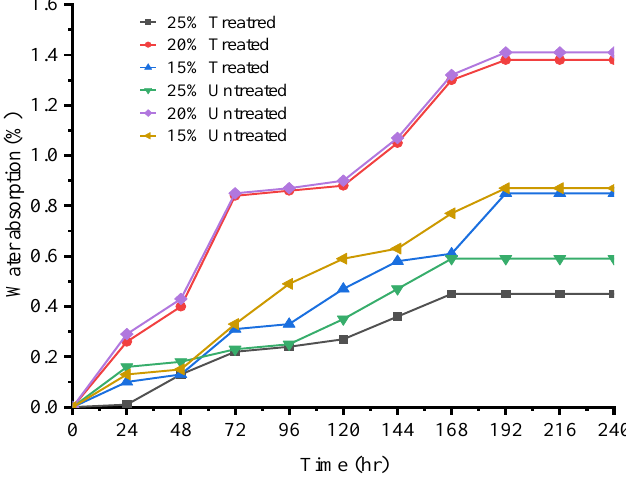
Figure 6. Moisture absorption test results of CH composites.